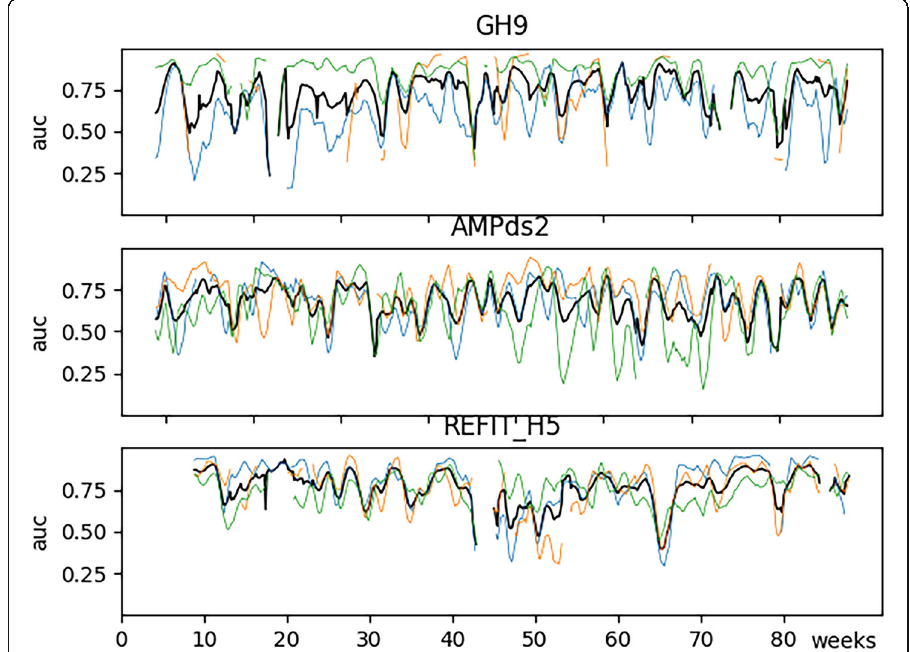
Fig. 1 AUC of the Histogram algorithm plotted over a 2 years horizon illustrating the large variations of the mean values in table 1 for all three datasets. The black curve is averaged over appliances, whereas the colored lines depict the individual appliances ’ performance. Red: tumble dryer, blue: dishwasher, green: washing machine. Interruptions in the lines result from a lack of sufficient values to confidently assess an AUC value for certain validation